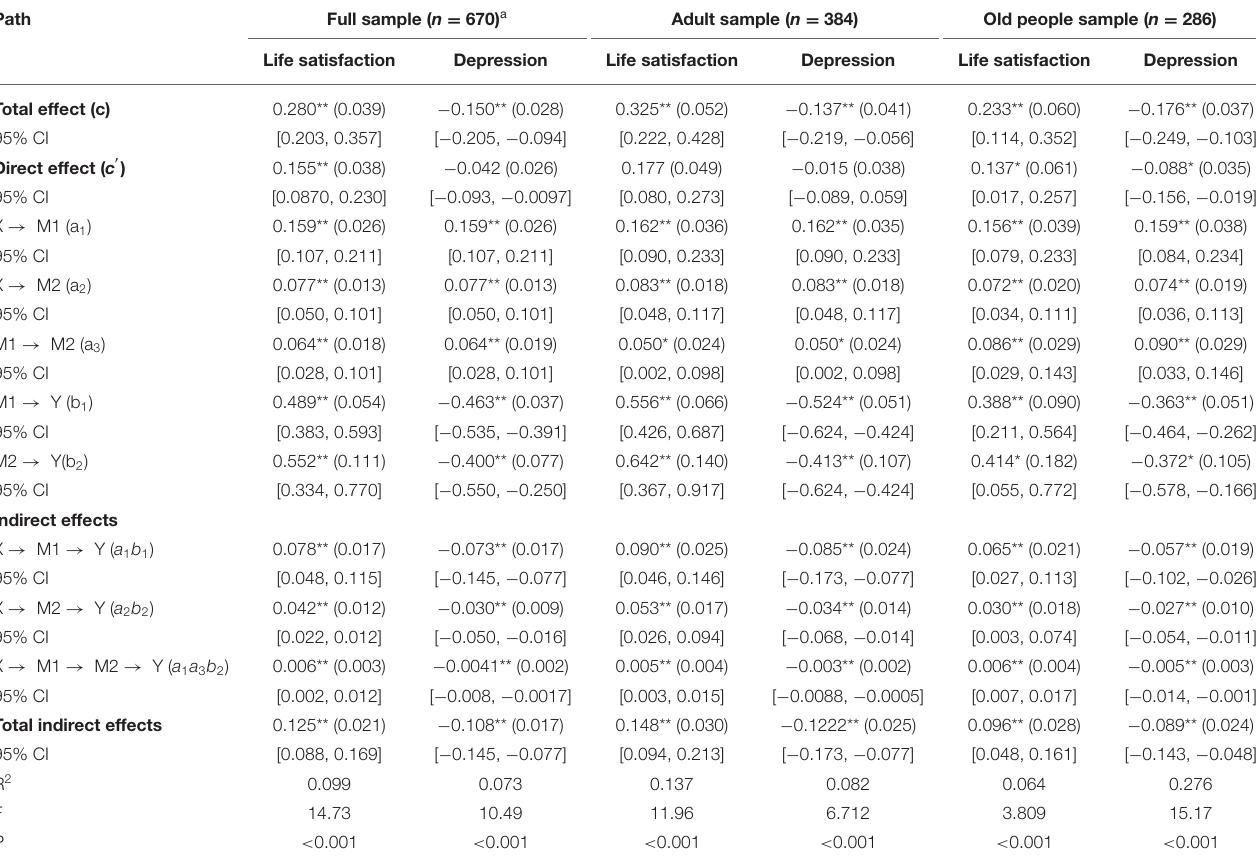
TABLE 4 | Path coefficients and standard errors after controlling gender, age, marriage status and education level from serial mediation models estimated using process. Path